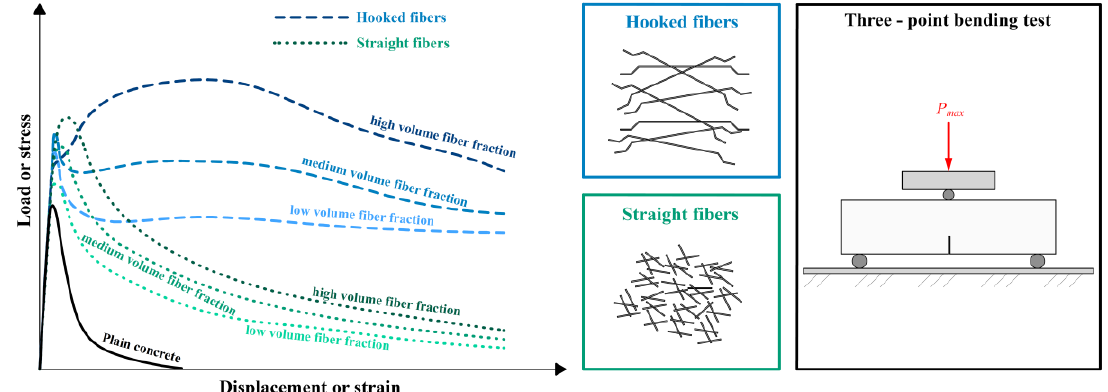
Figure 3. Load displacement diagram for fiber-reinforced concrete with hooked fibers and straight fibers [37].